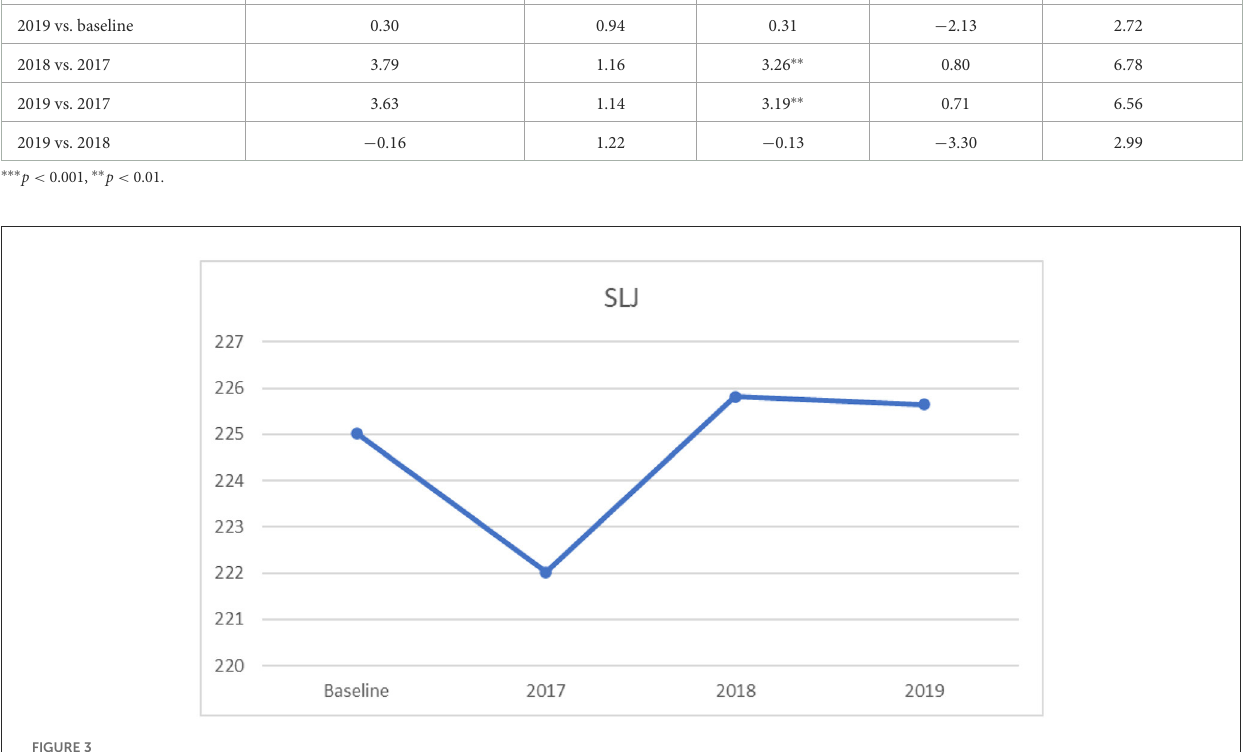
FIGURE3 Mean standing-long-jump scores: across baseline and years 2017–2019.